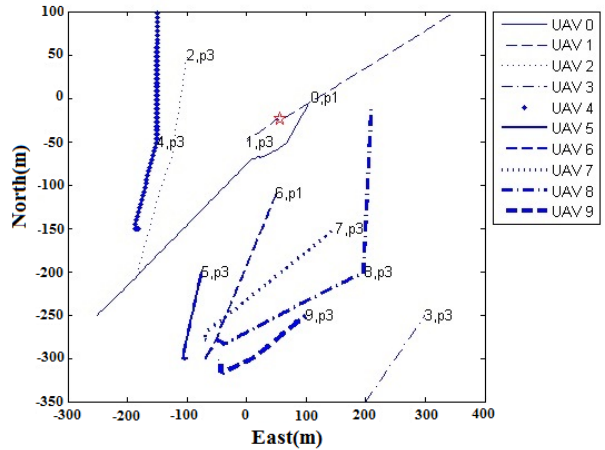
Figure 18. Case 3: Cooperative collision avoidance against temporary communication failure (unhealthy situation): Red star represents temporary communication failure at time 75 s, and UAVs 1 and 0 perform collision